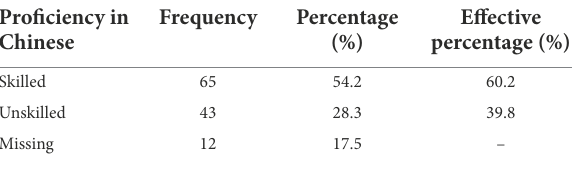
TABLE 3 Distribution of Chinese proficiency among international students in